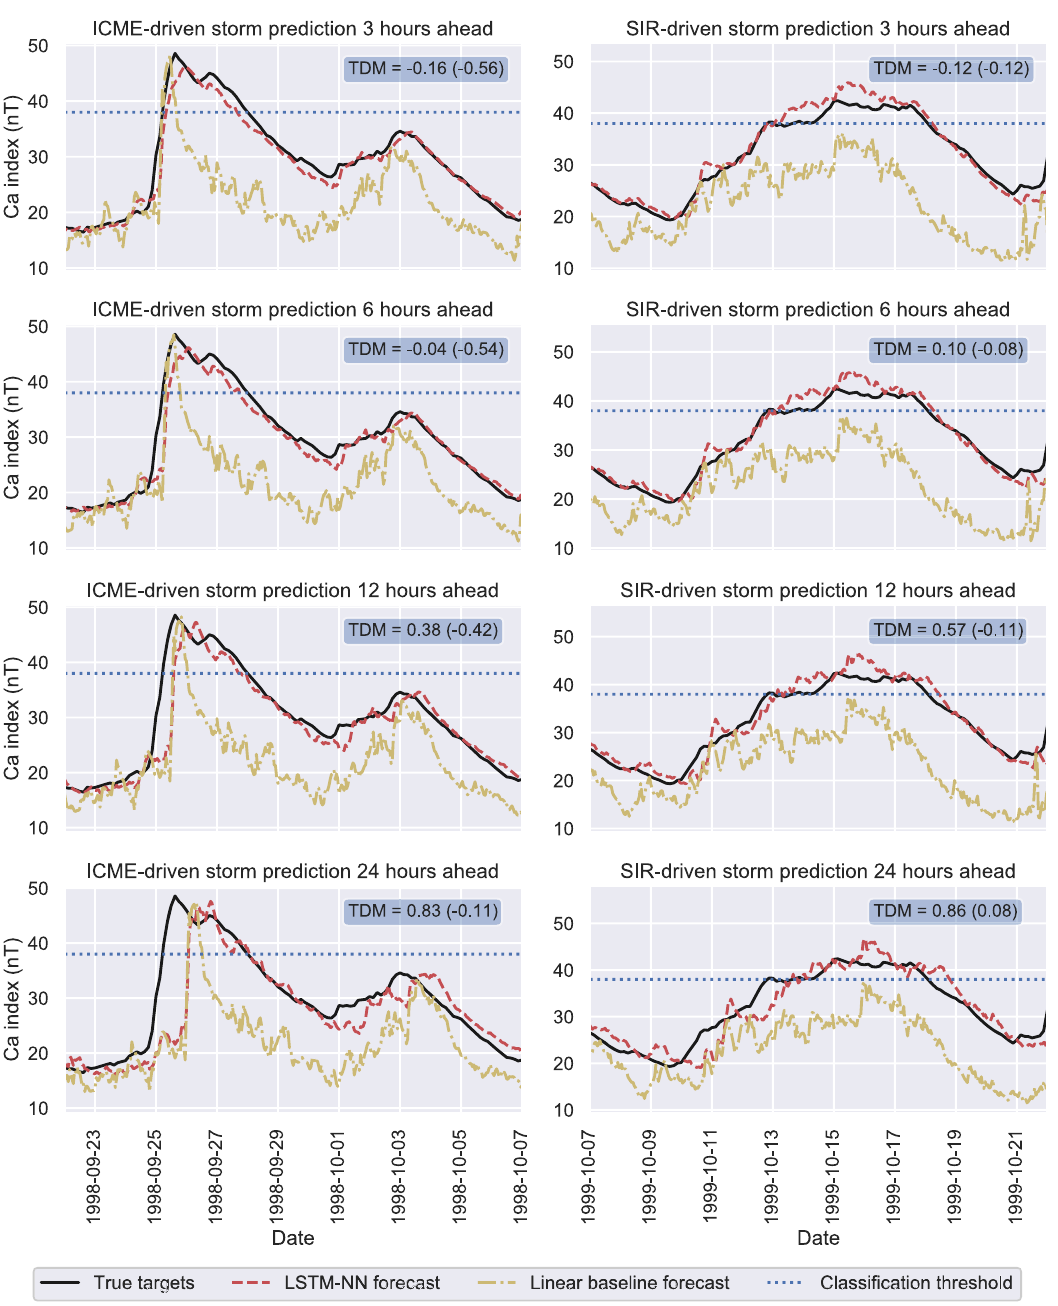
Fig. 6. Example of forecasts obtained with the LSTM-NN model and the linear model during two geomagnetic storms, the fi rst one (left-hand side) being an ICME-driven storm and the second one being a SIR-driven storm (right-hand side). Four different forecast horizons were used (3, 6, 12 and 24 h). The value of Ca used for the binary classi fi cation is the blue dotted line, given as a landmark. For each prediction, the corresponding TDM value is given (the TDM values for the baseline forecasts are given in